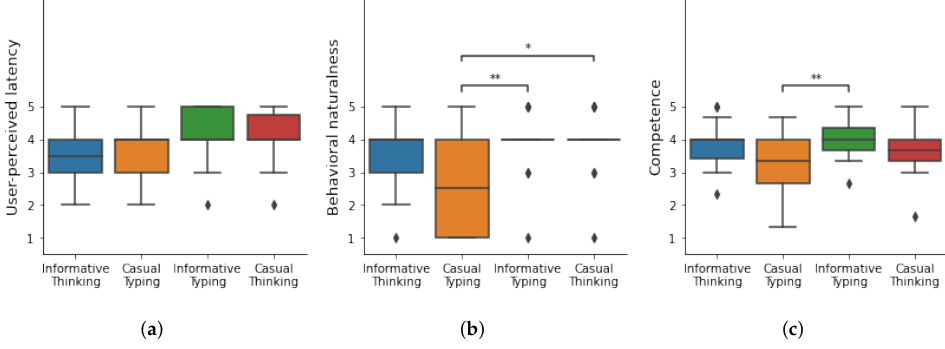
Figure 5. The results of ( a ) user-perceived latency, ( b ) behavioral naturalness, and ( c ) competence. (*: p < 0.05, **: p < 0.01) Table 2. Summary of the Friedman test results.